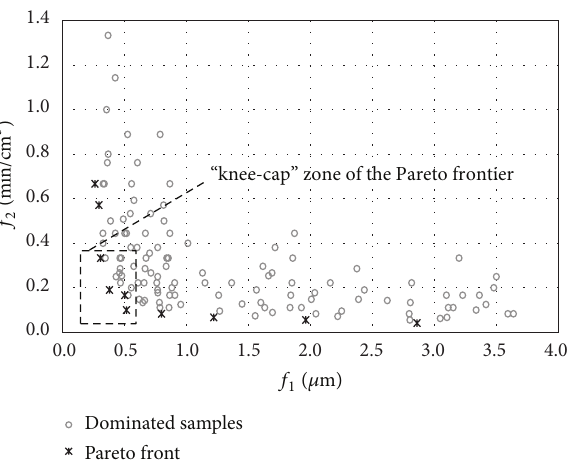
∗ Sample is within the “knee-cap” zone of the Pareto frontier.